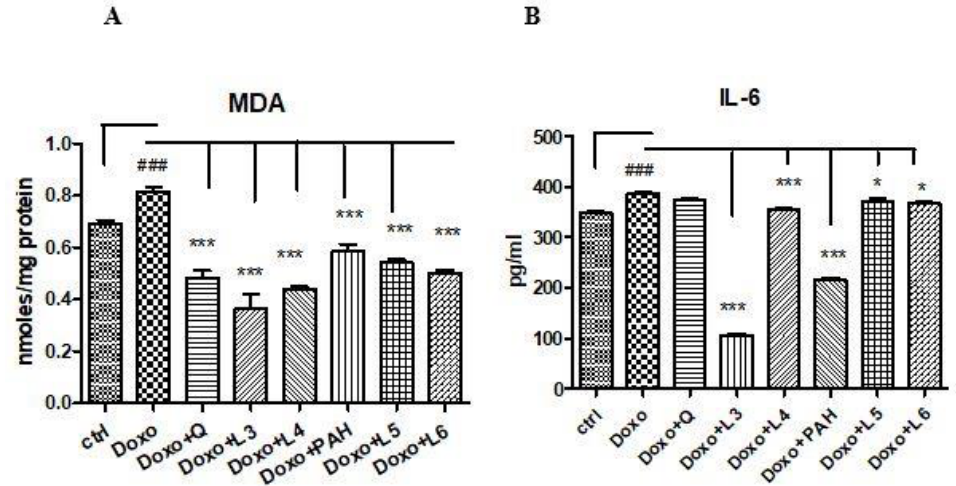
Figure 5. Malondialdehyde levels in the cell lysates, and IL-6 secretion in the supernates of the HUVECs exposed to Doxo and quercetin, the PAH extract and different formulations of liposomes. ( A ) MDA increased significantly after Doxo ad- ministration and diminished in the cells treated with quercetin ( p < 0.001), the PAH extract ( p < 0.001), L3 and L4 with